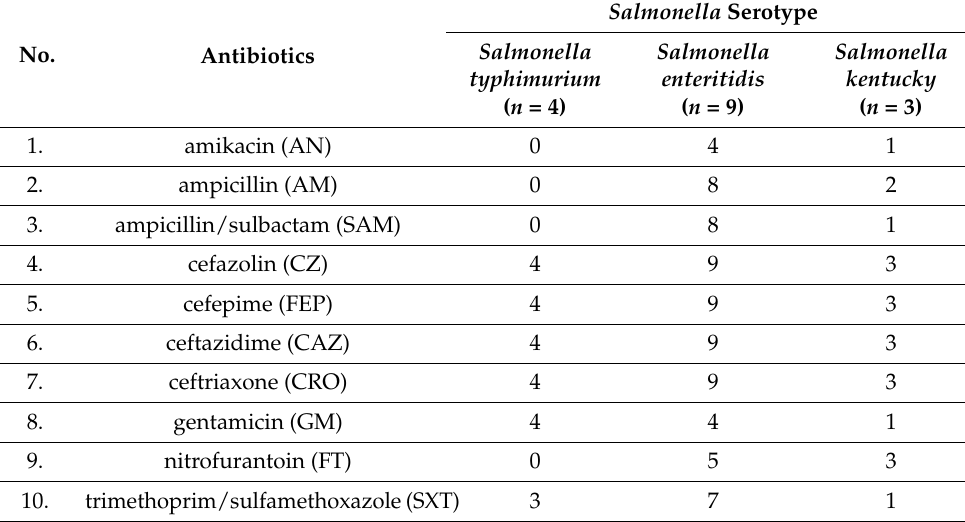
Table 5. Antimicrobial drug resistance profile of the isolated cat-origin Salmonella